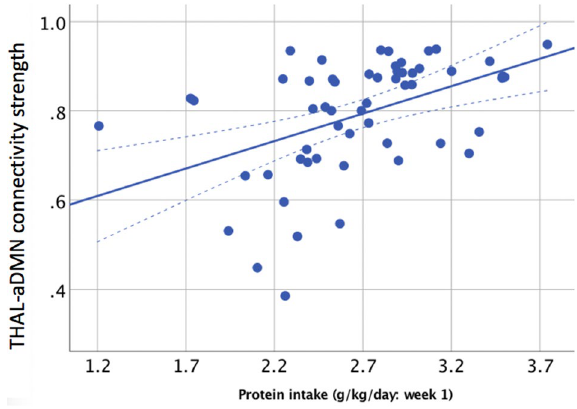
Figure 2. Relationship between functional connectivity strength in the thalamic and aDM resting state networks at 7 years (y-axis) and protein intake in the first week after birth